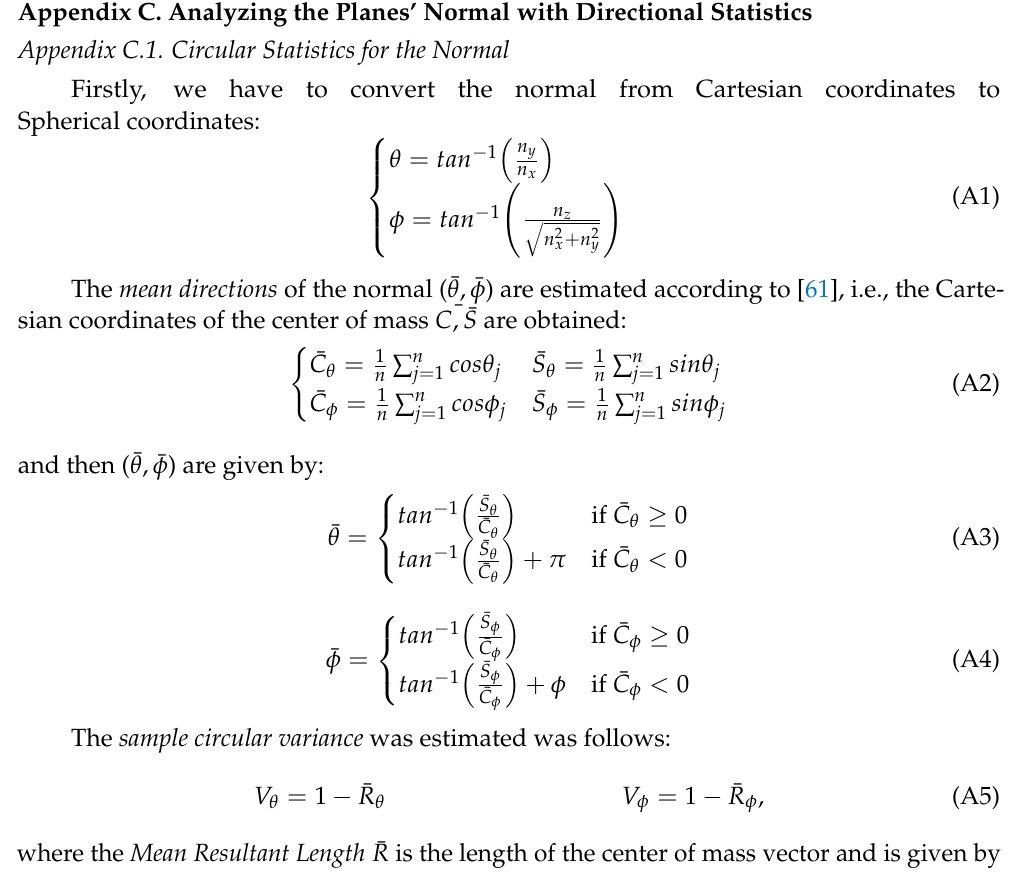
Figure A21. Results of orthogonal errors for the SR305 camera referring to the water milk4